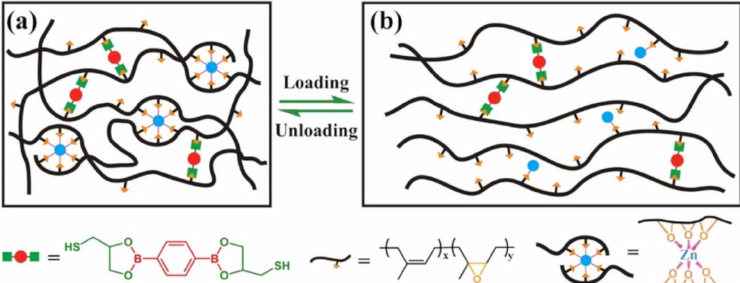
Figure 50. ( a ) Networks with dual cross-links of dynamic boronic ester bonds and non-covalent Zn 2 + –O coordination bonds. ( b ) Reversible breaking and reforming of Zn 2 + –O coordination bonds during loading-unloading tests. Reprinted with permission from [221]. Copyright (2019) American Chemical Society.